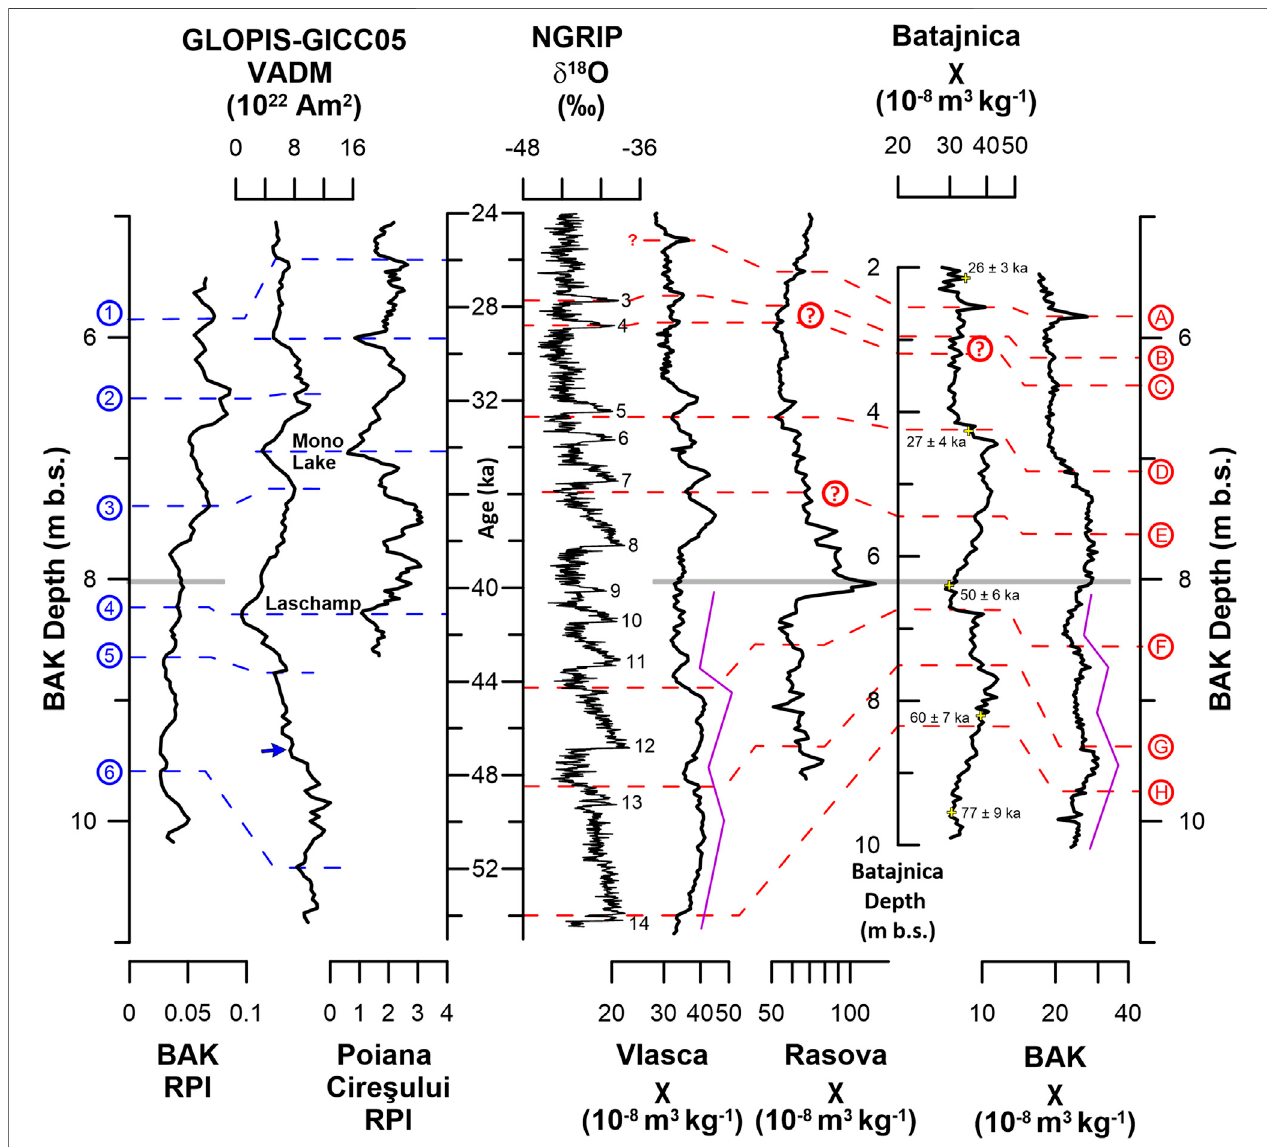
FIGURE6| Correlation oftheBAKpmag composite. ThepositionoftheCI/Y-5tephraisindicatedasagreyhorizontalline.RPIofBAKvs.depthiscorrelated(blue lines) with GLOPIS-GICC05 vs. age and compared to the RPI vs. age of the Poiana Ciresului site. The tie points are shown by blue numbers (1-6, cf. Table 3 ). The positions of geomagnetic excursions are noted. The blue arrow is described in the text. The χ vs. depth curve of BAK is correlated (red lines) with the χ vs. age curves of the sites Rasova and Vlasca, the χ vs. depth curve of Batajnica (note different scale) and the NGRIP δ 18 O (Greenland interstadials are numbered). Tie points of the magnetic susceptibility correlation are labeled A to H (cf. Table 3 ). Examples of stylized representations of the trend of the magnetic susceptibility in the lower part are shown with purple lines next to Vlasca and BAK. Tie points labeled with question marks are ambiguous and not considered for age modeling.